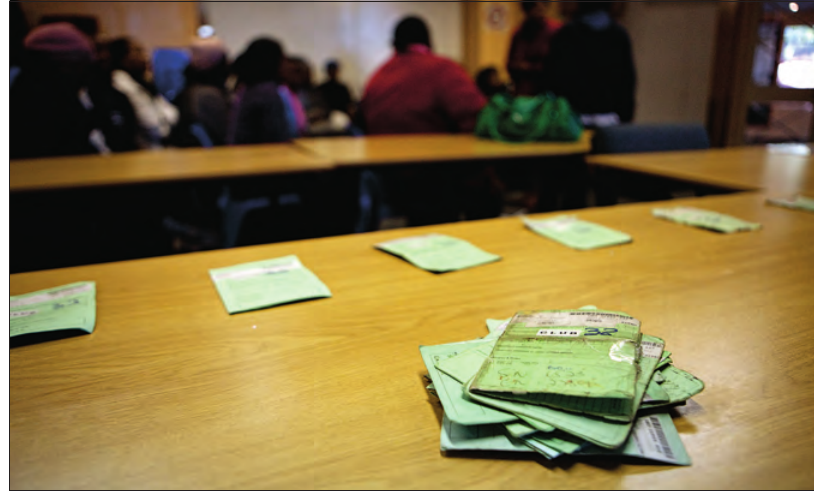
Fig. 2. Patients at an ART adherence club